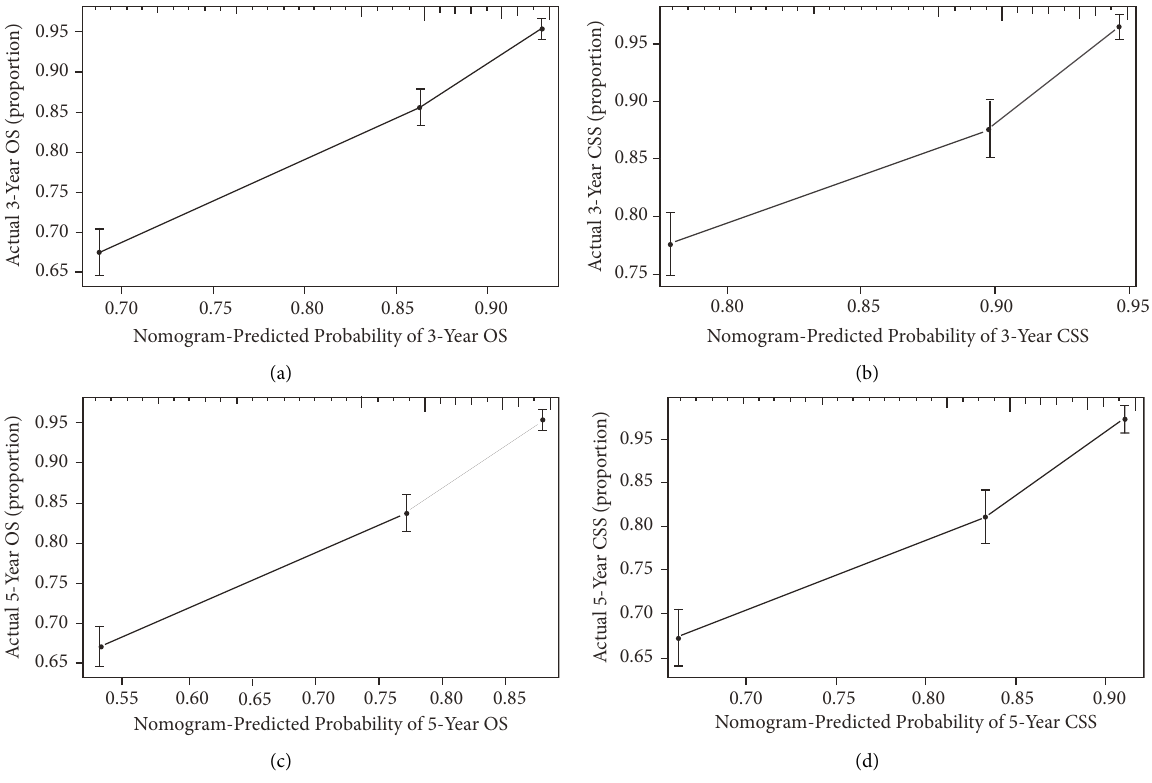
Figure 4: Calibration curves of internal validation for predicting 3-year OS (a), 3-year CSS (b), 5-year OS (c), and 5-year CSS (d). OS: overall survival and CSS: cancer-specific survival.